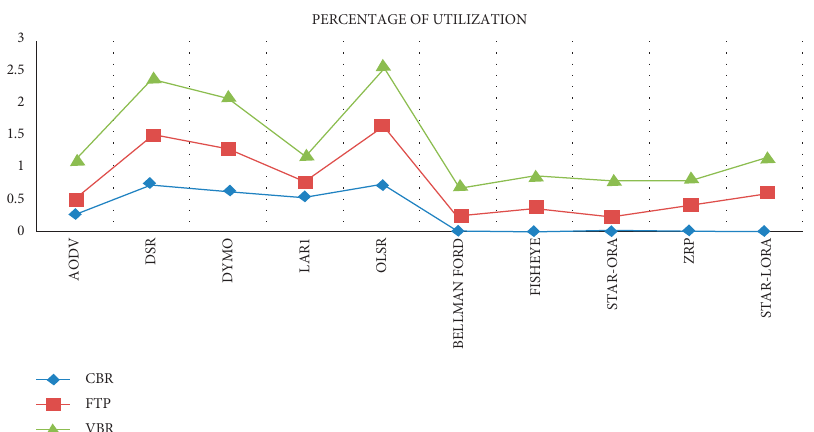
Figure 19: Percentage of utilisation of all routing protocols for 120 nodes.